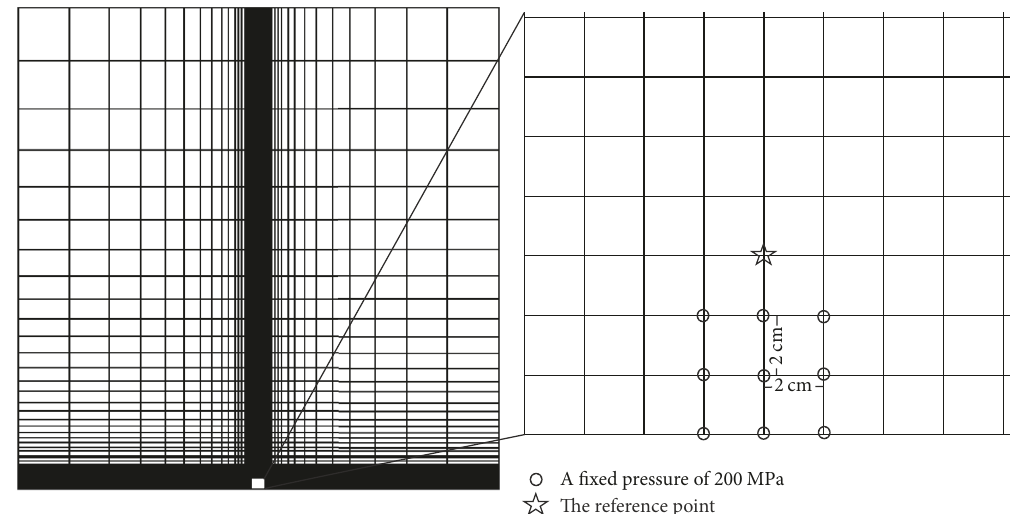
Figure 3: The finite element meshes of the model. The left figure shows the whole meshes in the model. The right figure shows the finer meshes (2 cm × 2 cm) in the parts close to the fluid source. The reference point is above the nodes where a fluid pressure of 200 MPa is fixed.